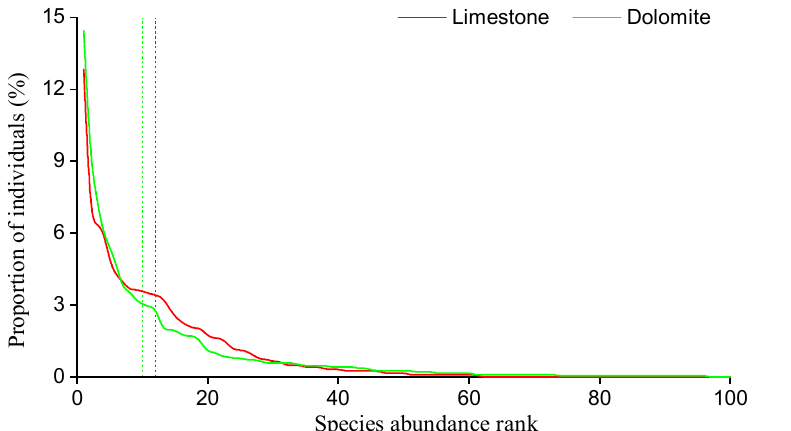
Figure 2. Species accumulation curves (SACs) relating total species richness to dolomite and lime- stone karst-forest sampling-plot treatment. The solid line represents the SAC and the dashed line represents one positive standard deviation.